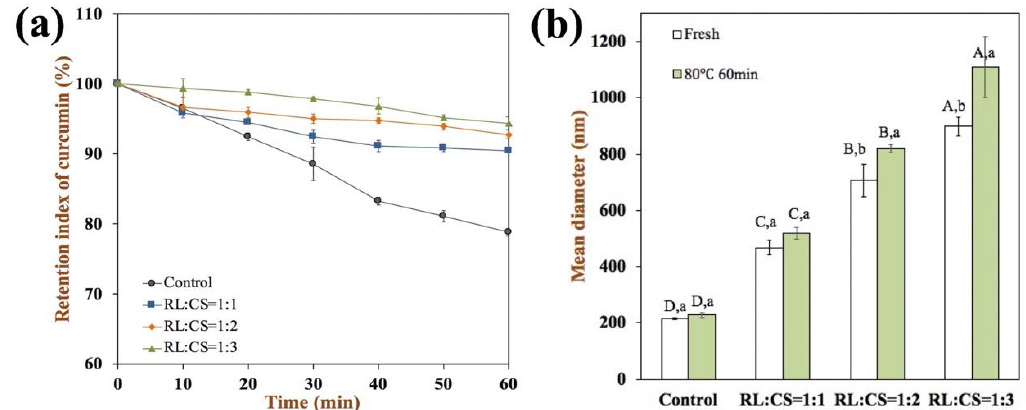
Figure 5. Degradation ( a ) and mean diameter ( b ) of Cur-loaded liposomes with different ratios of RL/CS at 80 °C for 60 min. Samples denoted by different capital case letters (A – C) were significantly different ( p < 0.05) when compared between different RL/CS ratios. Samples denoted by lowercase letters (a – c) were significantly different ( p < 0.05) when compared between different treatment condition.